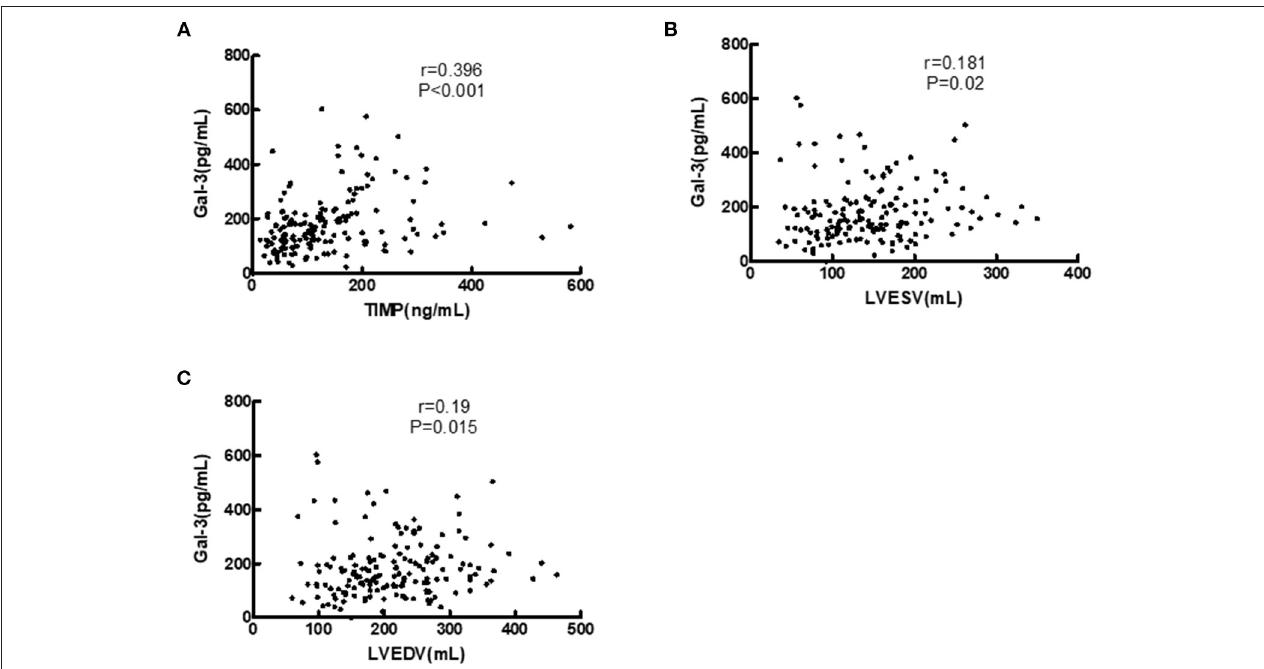
FIGURE 3 | Correlations of serum Gal-3 levels with TIMP-1, LVEDV, and LVESV in HF patients. (A) Correlation of Gal-3 with TIMP-1. (B) Correlation of Gal-3 with LVESV. (C) Correlation of Gal-3 with LVEDV. Gal-3, galectin-3; LVESV, left ventricular end systolic volume; LVEDV, left ventricular end diastolic